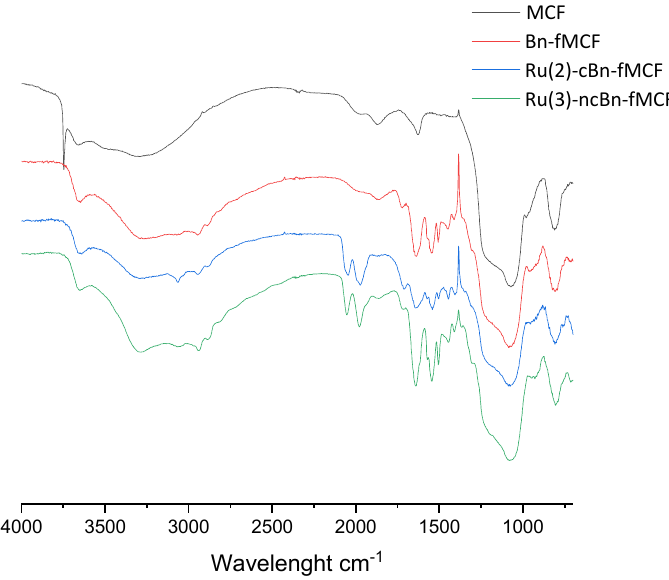
Figure 3. IR spectra of native MCF and its functionalization products.